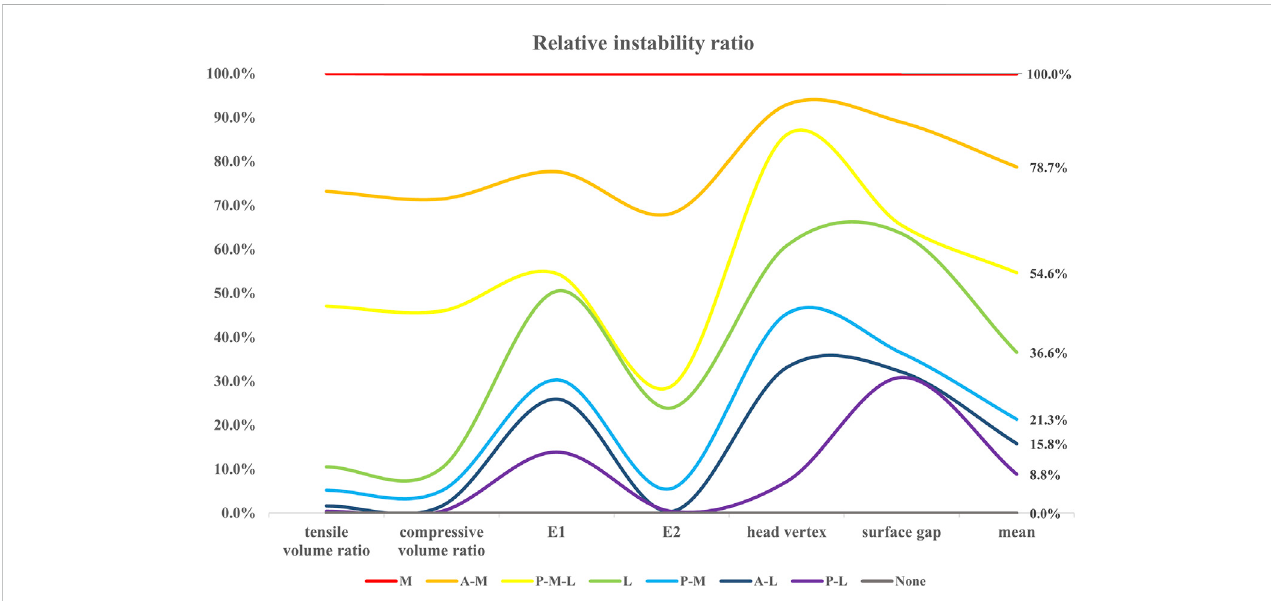
FIGURE 11 Therelativeinstabilityratioofeachmodelconcerningthesixoutcomeindicatorswereexhibited,andthecorrespondingmeanvalueswereshowninthe last